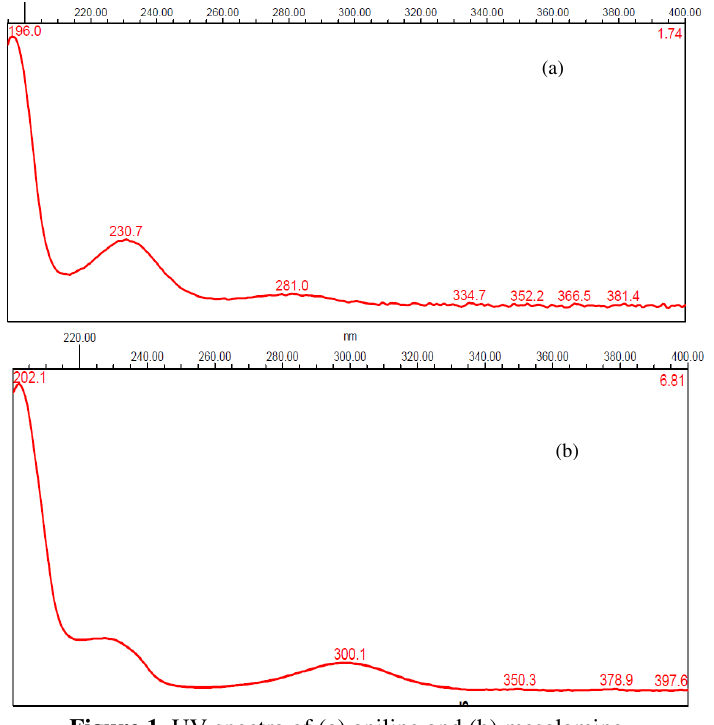
Figure 1. UV spectra of (a) aniline and (b)